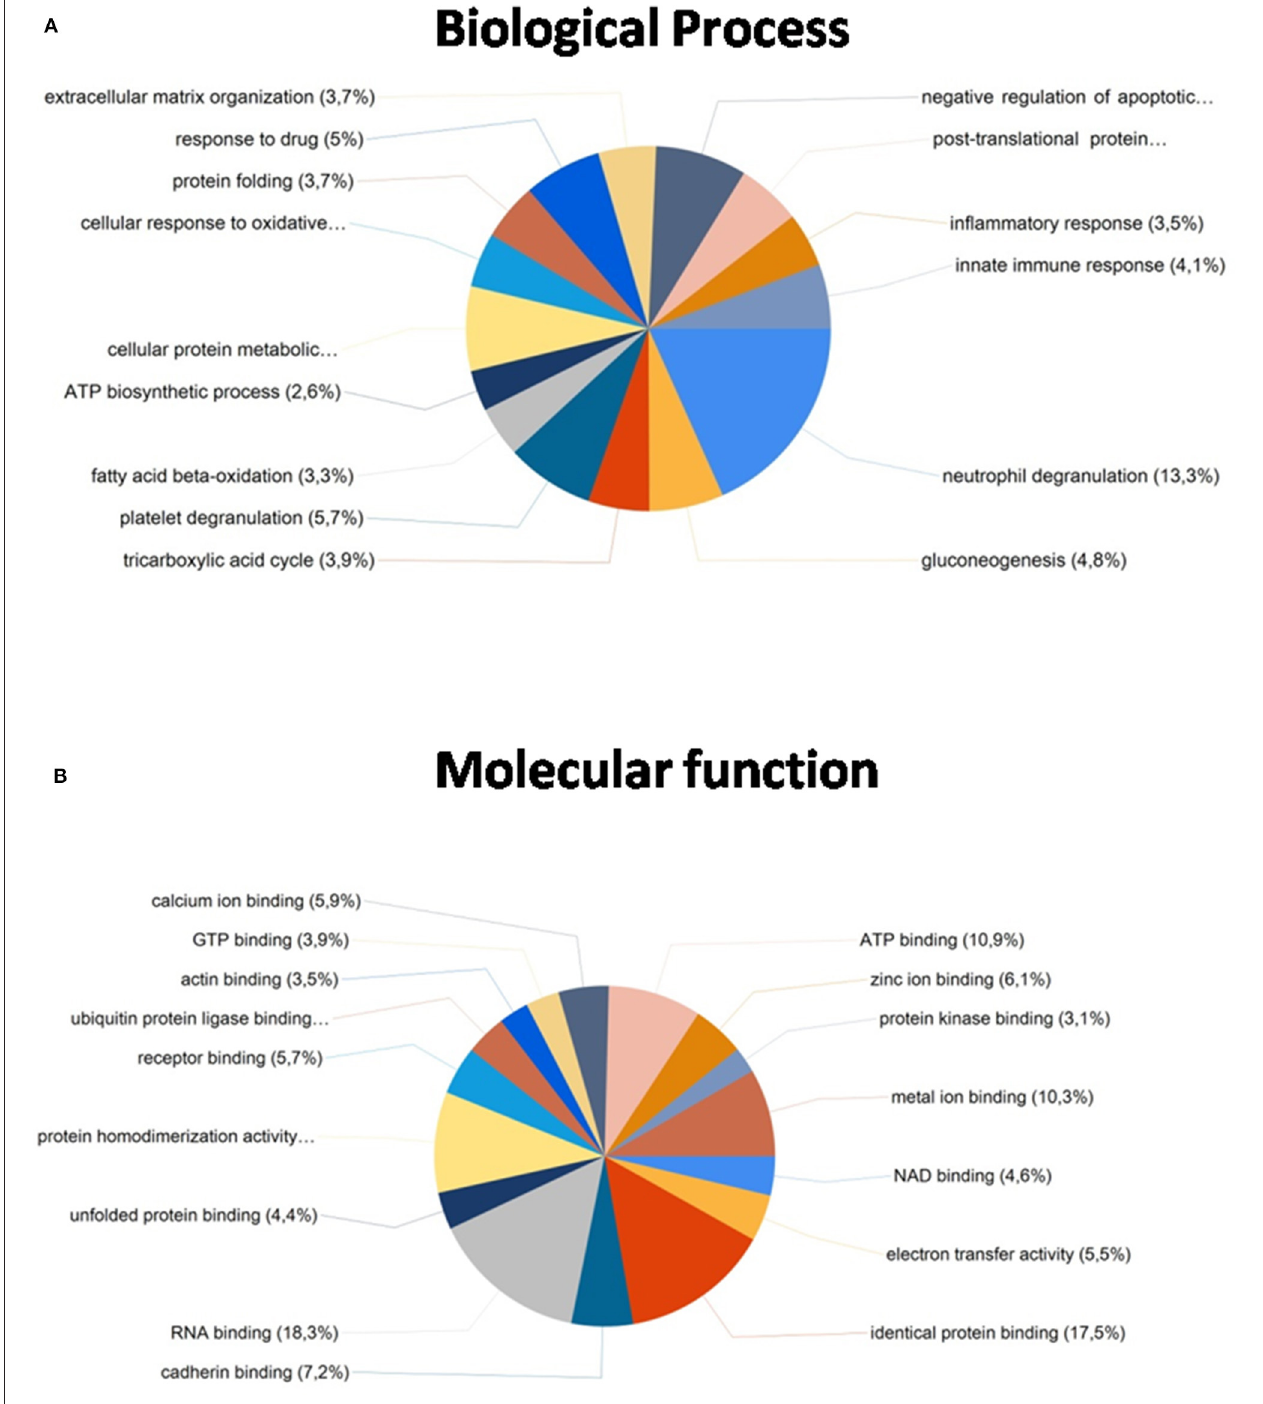
FIGURE 6 | Functional classification of the 468 common proteins identified after the extraction with the five SDS-containing buffers according to their (A) biological process and (B) molecular function, using the FunRich program. FFPE renal samples. Importantly, proteins extracted were identified by LC-MS/MS analysis (see Figure 12 ), showing a total of 8, 10, and 25 proteins, respectively. Further insights